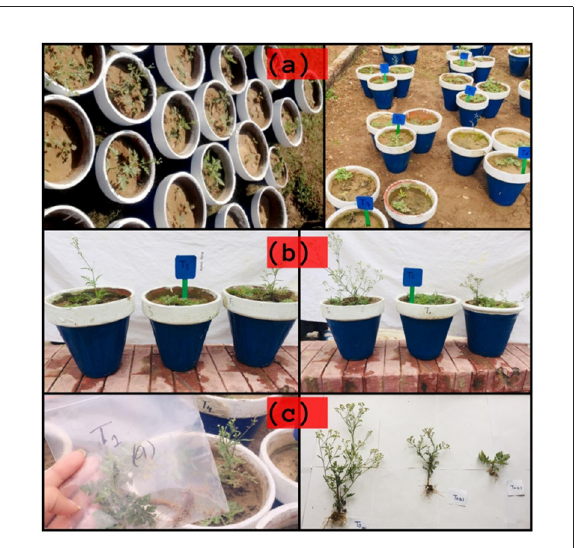
FIGURE1 (a) Plants at seedling stage, (b) post treatment growth of seedlings, and (c) collection of plants for further processing.